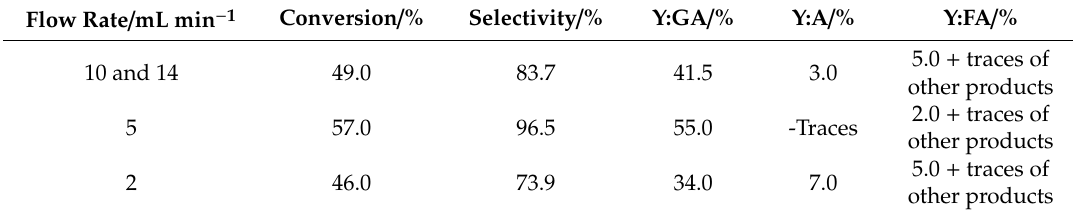
Figure 3. NMR product spectra with identified peaks, black line: initial solution; blue line: final solution after 7 h of reactor operation. Table 1. Nuclear magnetic resonance (NMR) analysis of reaction solutions after 7h in electroenzymatic reactors tested at three di ff erent flow rates (Corresponding spectra shown in Supporting information, Figure